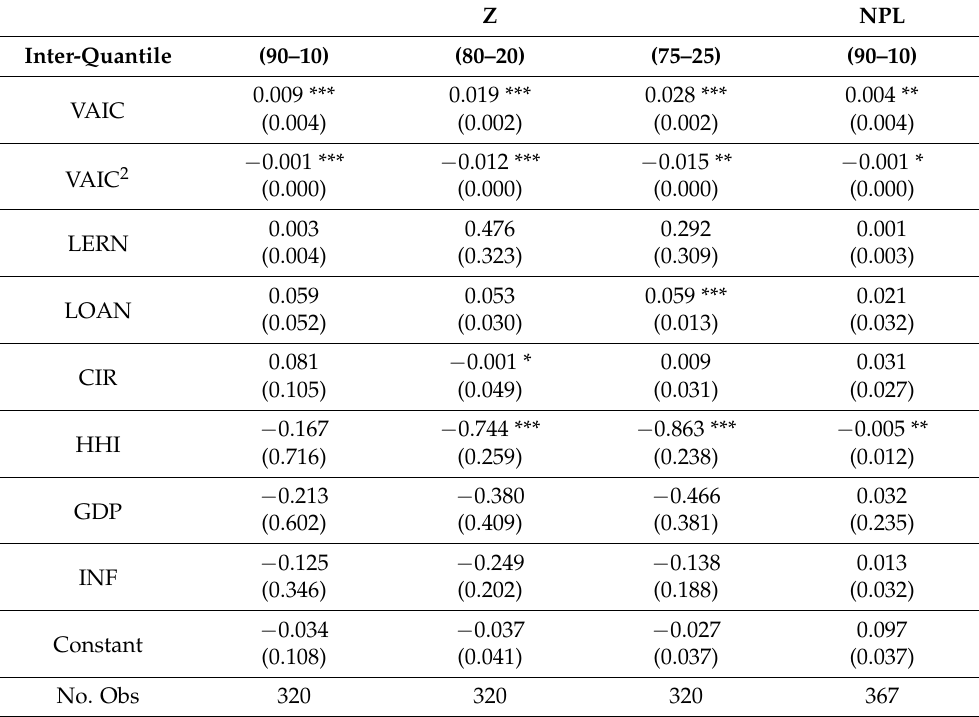
Table 8. The results of inter-quantile regression VAIC.